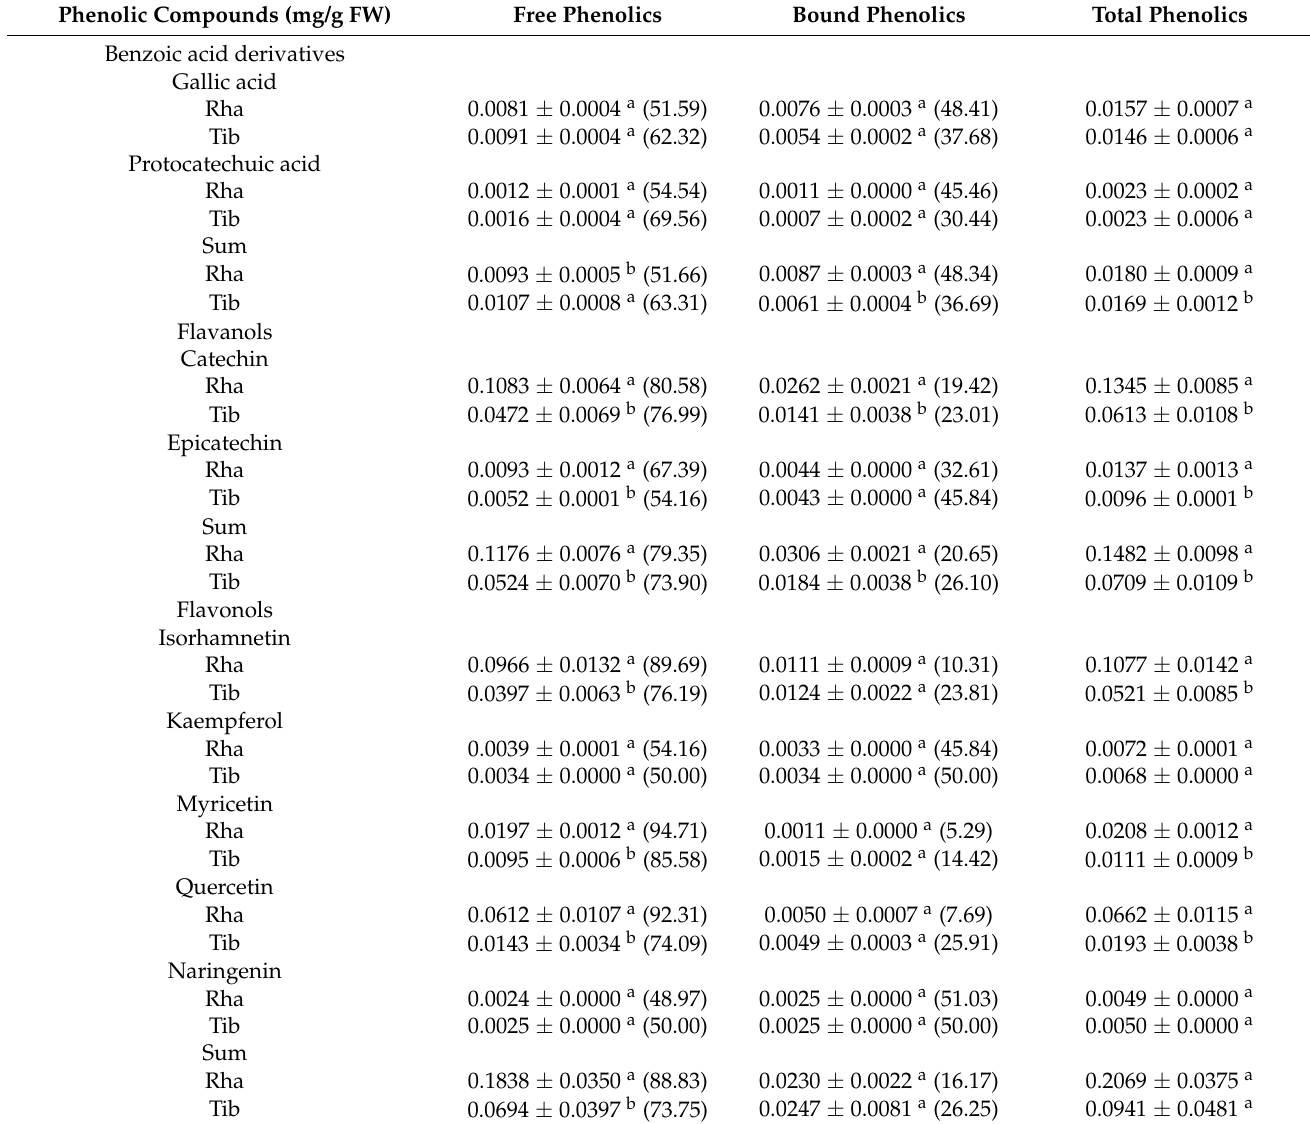
Table 1. Phenolic compound content of Rha and Tib